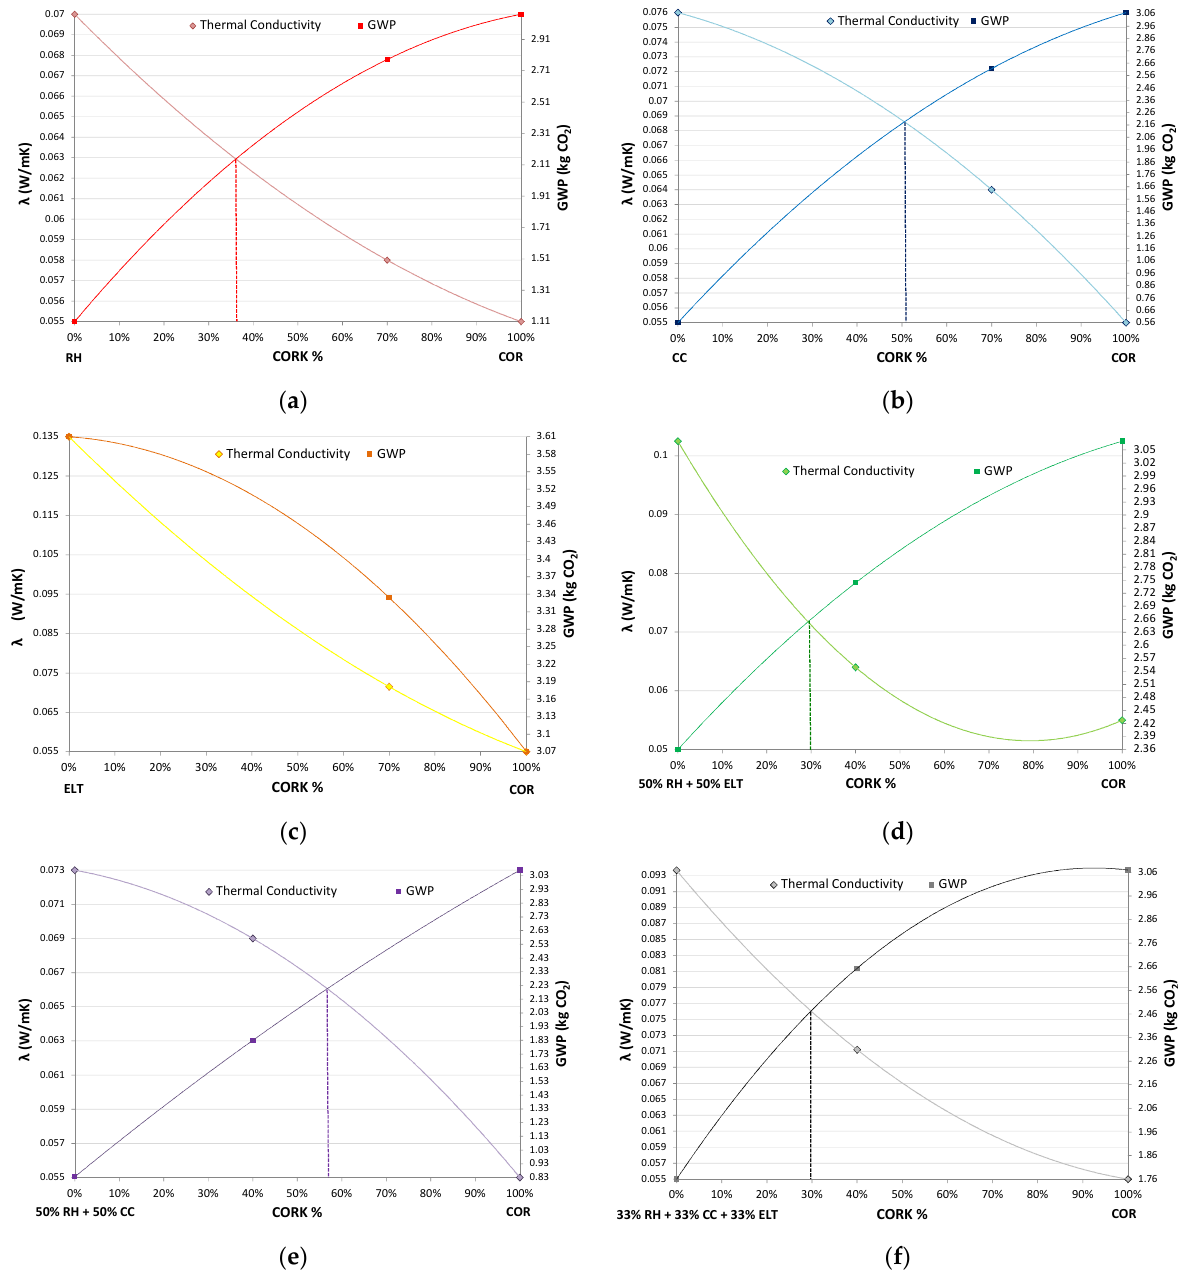
Figure 4. Cross-comparative analysis of the panels in terms of thermal conductivity and GWP for 1 m 2 of panel: ( a ) panel 1; ( b ) panel 2; ( c ) panel 3; ( d ) panel 4; ( e ) panel 5; ( f ) panel 6. Table 8. Global Warming Potential and Thermal Conductivity values obtained for the best identi- fied mixture (in the grey column the best mixing ratios are reported).